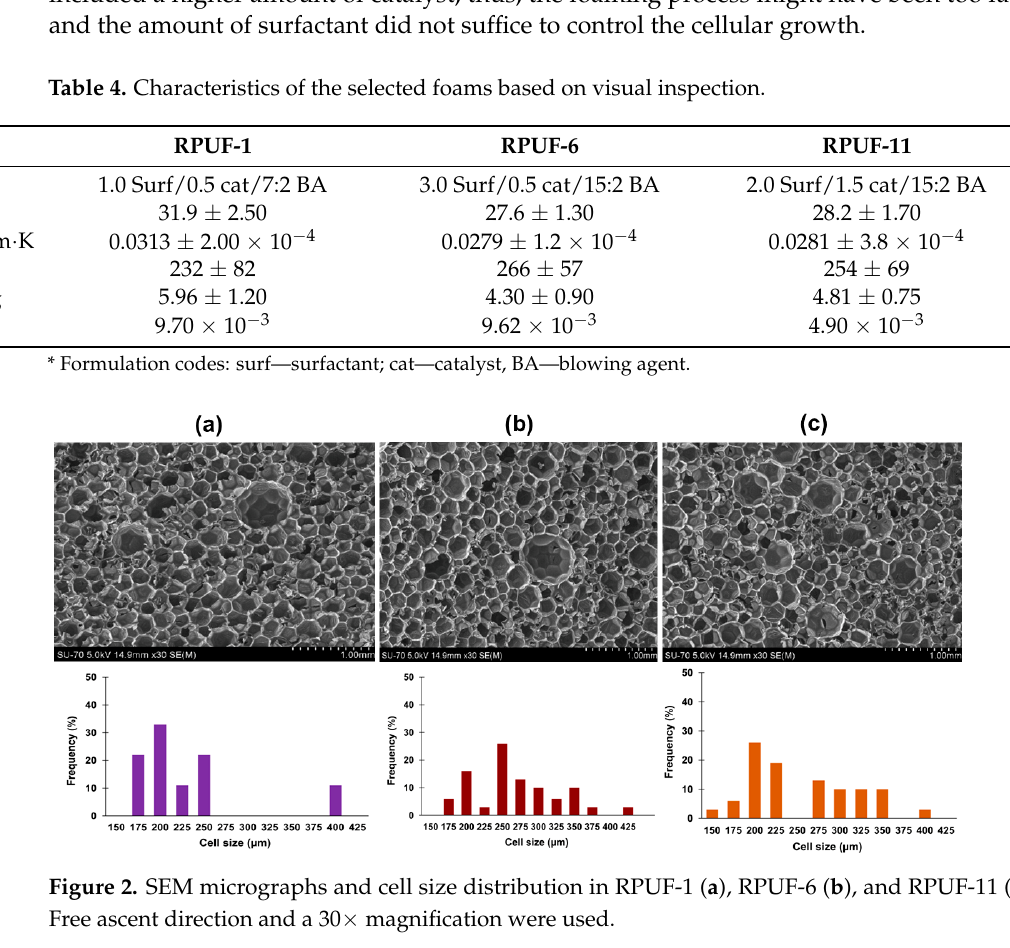
Table 5. Validation of the fitted model for I OH and viscosity. Run